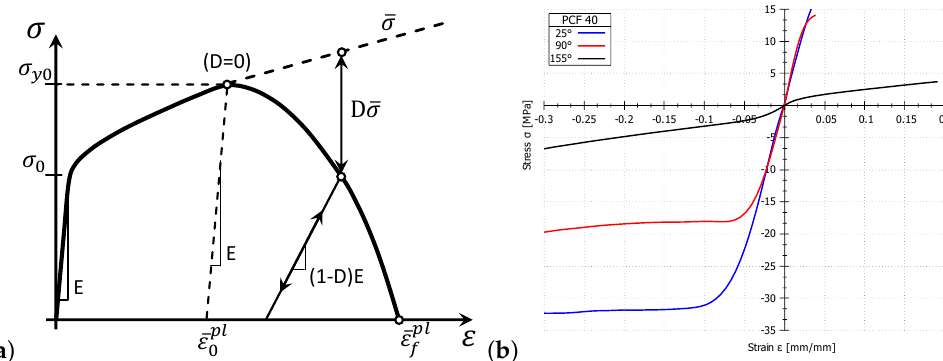
Figure 3. ( a ) Typical stress–strain curve for a material model with failure due to progressive damage simulated in Abaqus for specimen during a simple tensile test [22], ( b ) typical stress–strain curves for sample loaded by a 45 mm/min strain rate (40 PCF PUR foam).